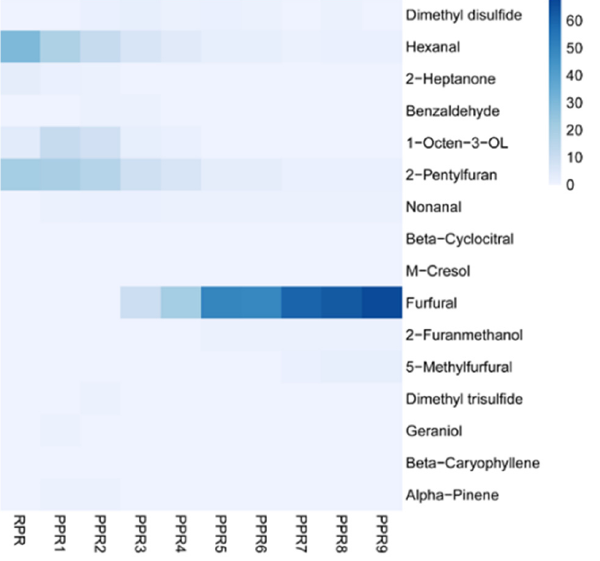
Figure 7. Heatmap of key flavor components of PR samples with different processing levels. The colors from white to blue represent the relative amounts of the flavor components from low to high.